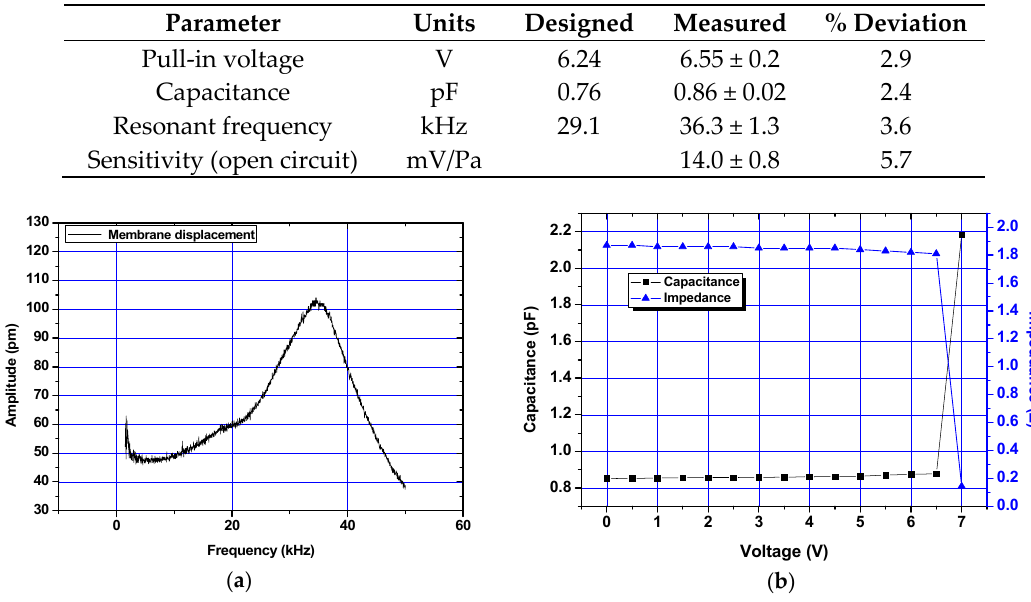
Figure 5. Measurement results of the fabricated MEMS microphone: ( a ) frequency response; ( b )